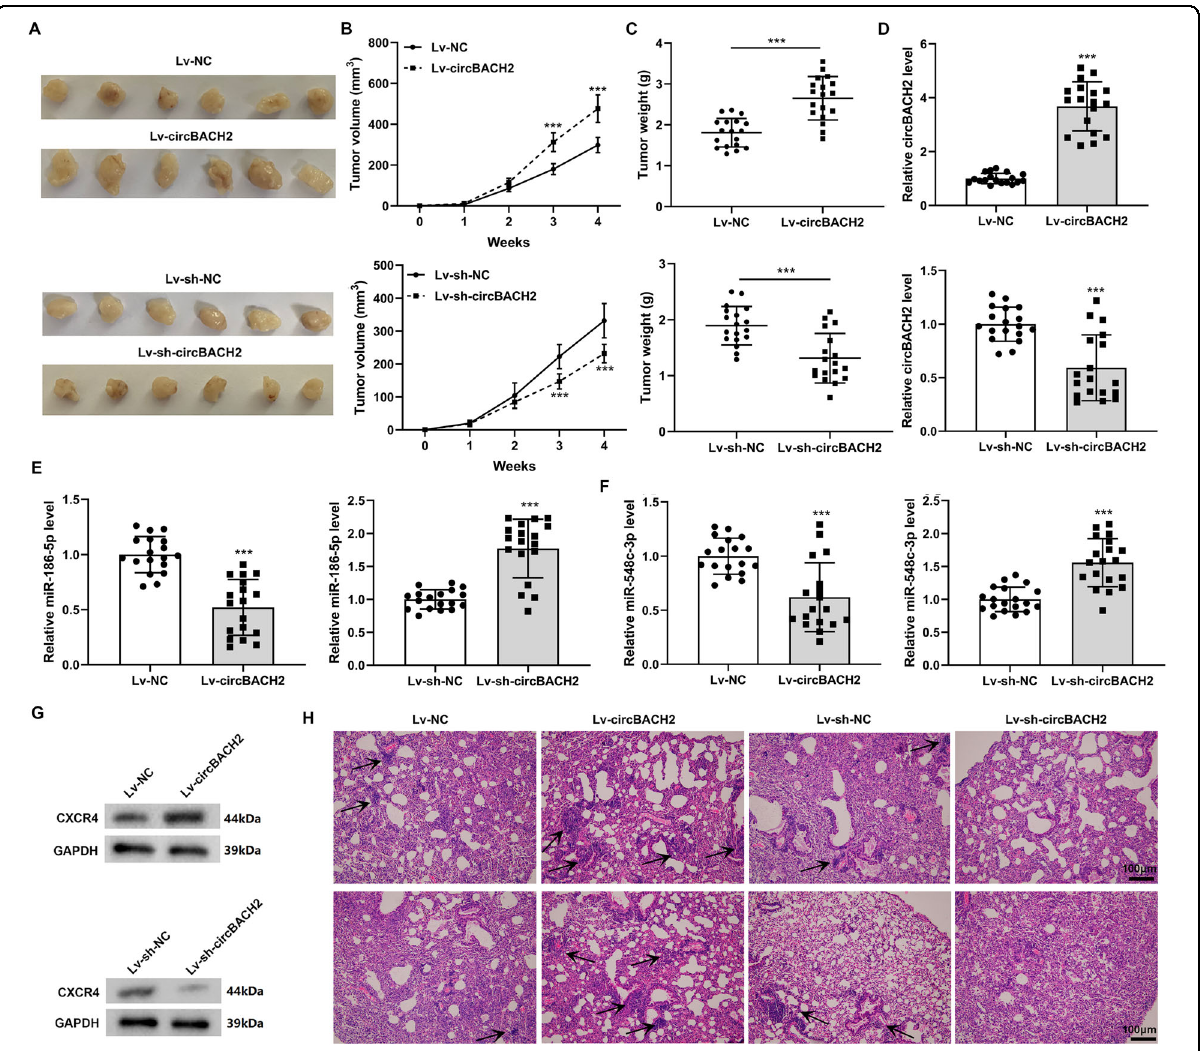
Fig. 8 circBACH2 promoted the progression of TNBC in vivo. MDA-MB-231 cells were transfected with Lv-circBACH2 or Lv-sh-circBACH2 or corresponding controls (Lv-NC or Lv-sh-NC) and subcutaneously injected into the nude mice. A The xenografted tumors photos of mice ( n = 6). The tumor B volumes and C weights of mice. *** P < 0.001. MDA-MB-231 cells were transfected with Lv-circBACH2 or Lv-sh-circBACH2 or corresponding controls (Lv-NC or Lv-sh-NC) and transplanted into the nude mice by tail vein injection. n = 6 of each group. D The expression level of circBACH2 in the lung tissues of mice. The expression levels of E miR-186-5p and F miR-548c-3p in the lung tissues of mice. G The CXCR4 protein level in the lung tissues of mice. H Representative HE staining (scale bar = 100 µm) for lung tissues of mice in each group. Arrows: metastatic nodules. *** P < 0.001 vs Lv-NC or Lv-sh-NC. B – F the experiment was repeated three times with tumor samples from six